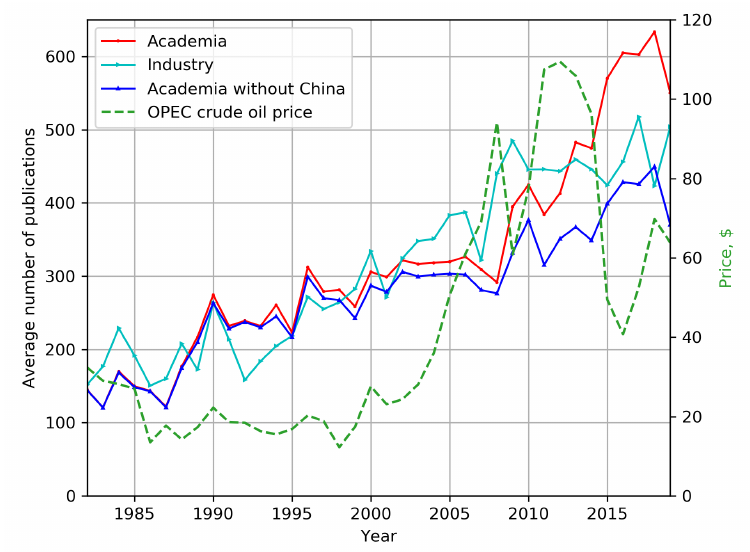
Figure 3. The annual publication contributions by industry and